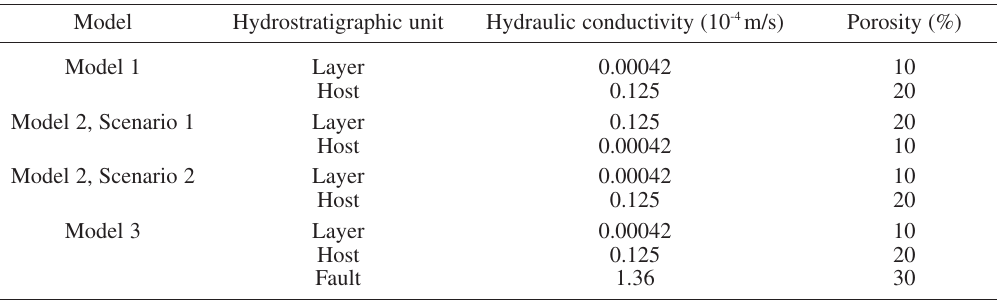
Table II. Hydraulic